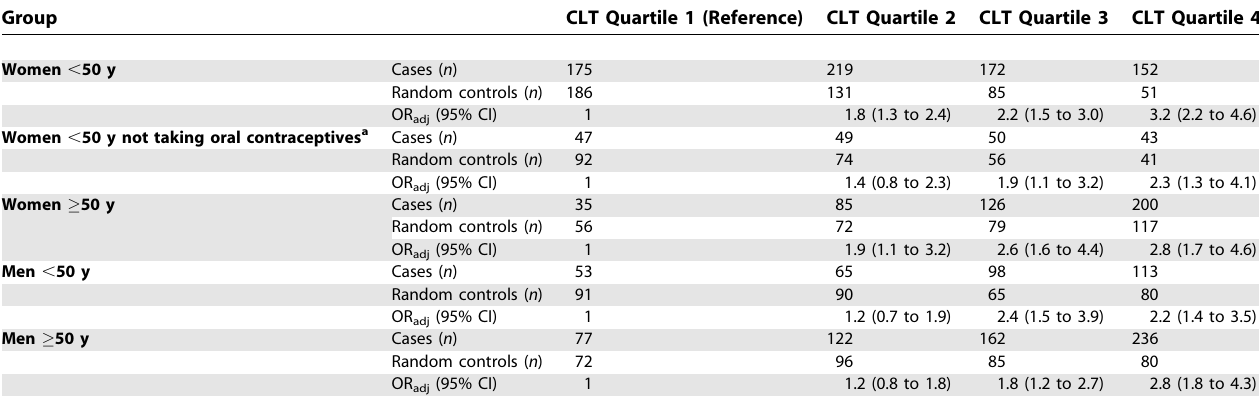
Table 3. Relative Risk of Venous Thrombosis According to Quartiles of Clot Lysis Time